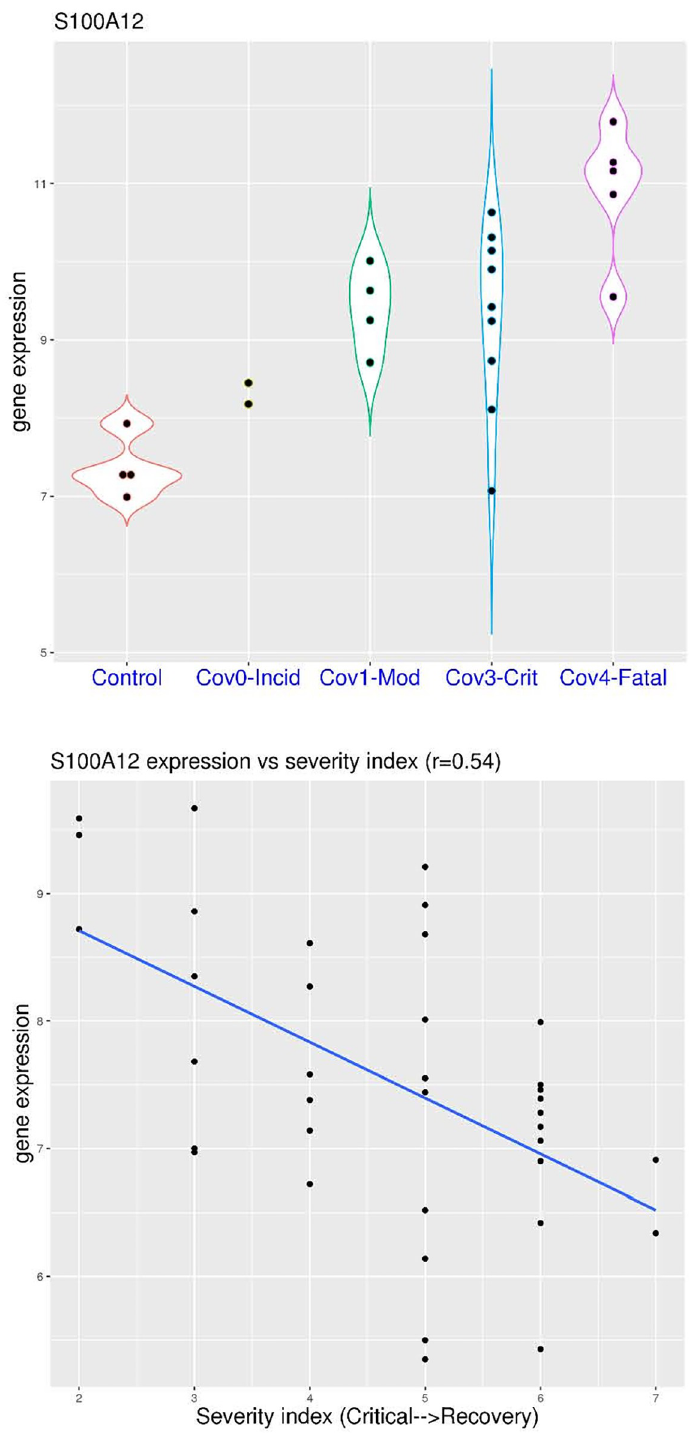
Fig 4. Correlation of S100A12 expression and the severity of COVID-19 (whole blood). A) upper panel (dataset GSE189990), comparison of S100A12 expression in COVID-19 patients with different severity (incidental, moderate, critical and fatal). B) lower panel (dataset GSE161777), correlation between S100A12 expression and severity index (from critical to recovery).